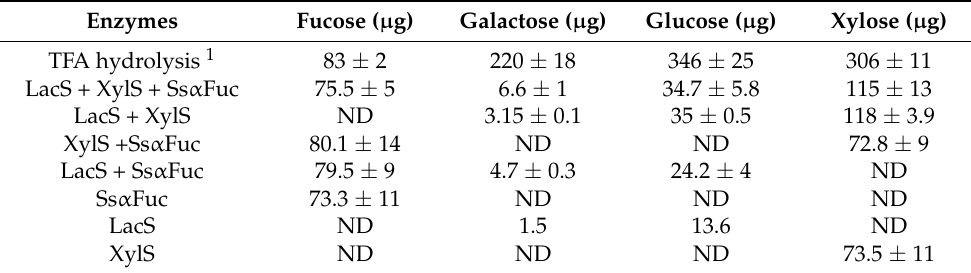
Table 2. Enzymatic hydrolysis of XGO2 after 20 h by using LacS, XylS and Ss α Fuc. Enzymes